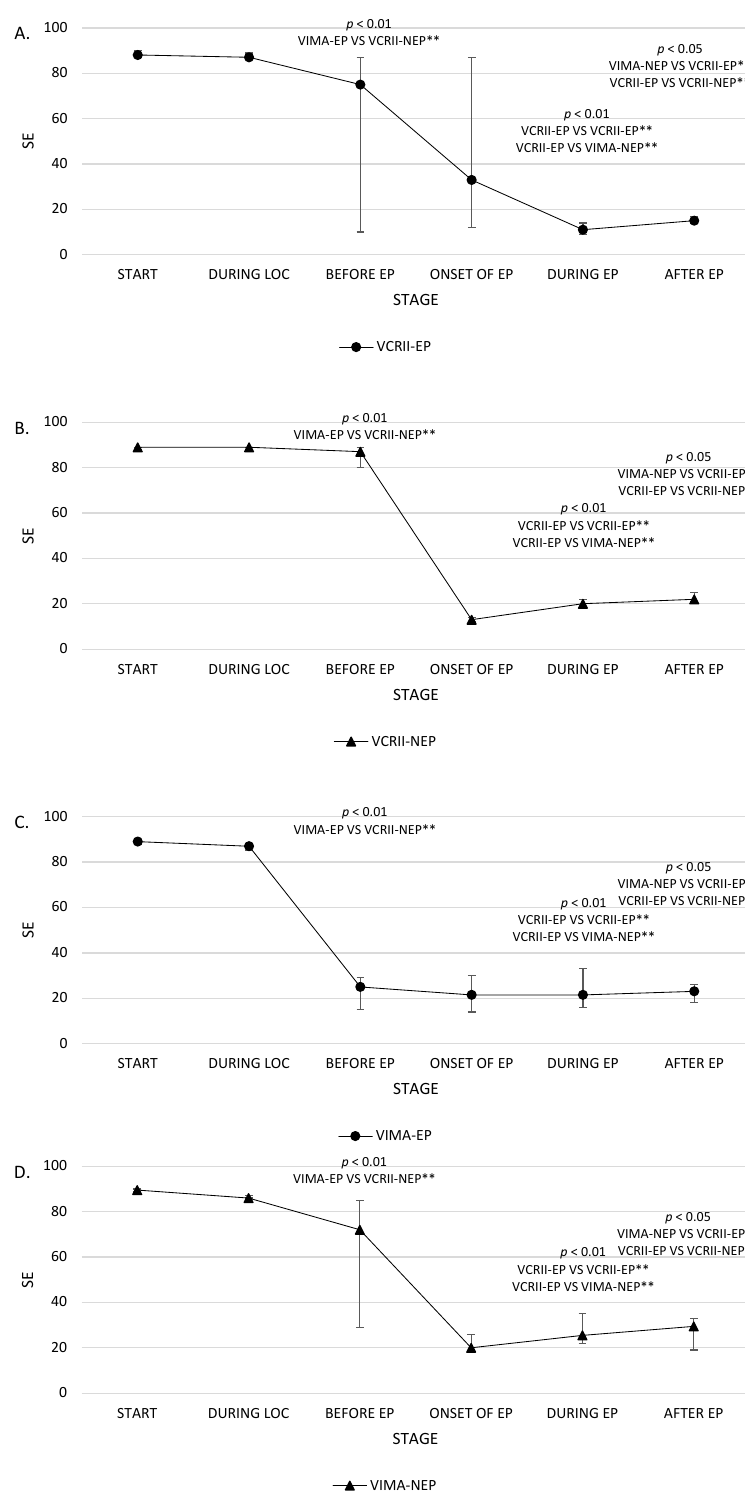
Figure 1. Medians with interquartile range (M (IQR)) of state entropy (SE) in groups: ( A ) volatile-vitalcap-EPI (VCRII-EP), ( B ) volatile-vitalcap-NOTEPI (VCRII-NEP), ( C ) (VIMA-EP), ( D ) (VIMA-NEP), on separate stages of the study, indicating a sequence of events ( p -values: * <0.05, ** <0.01, *** <0.001).